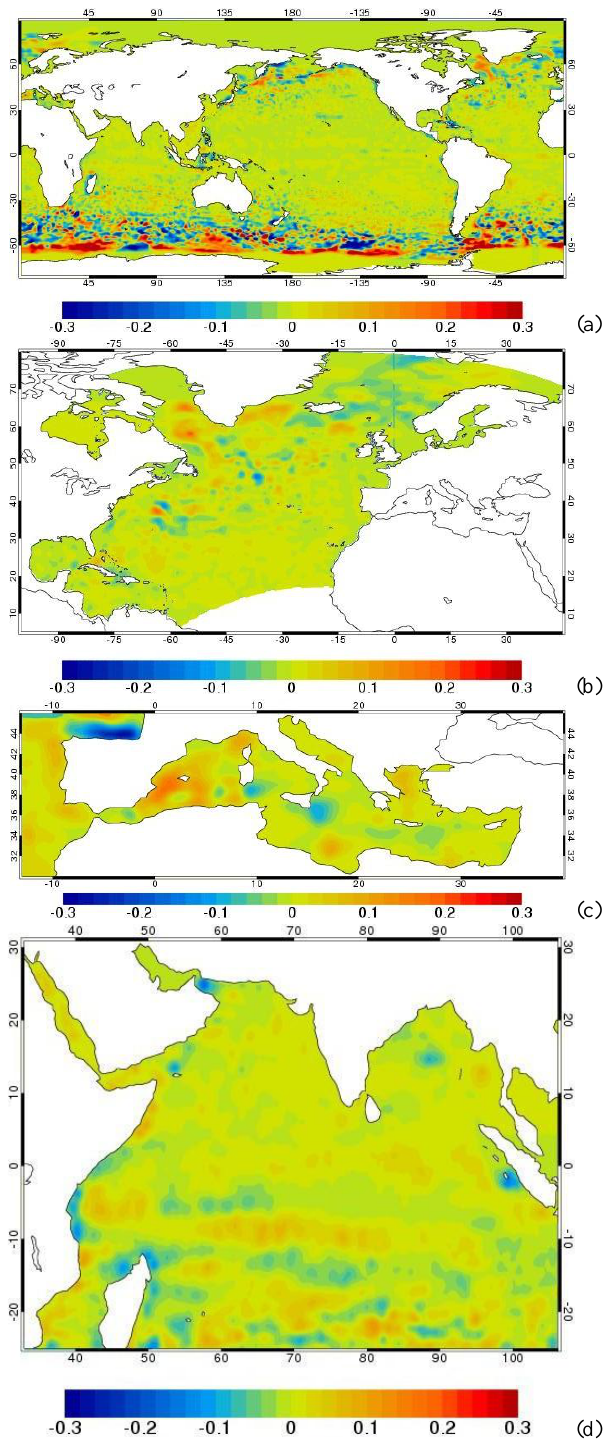
Fig. 7. Observation bias, in m for the Met Office NEMO operational models (19 August 2009). (a) 1/4 degree global, (b) 1/12 North At- lantic, (c) 1/12 degree Mediterranean (d) 1/12 degree Indian Ocean.